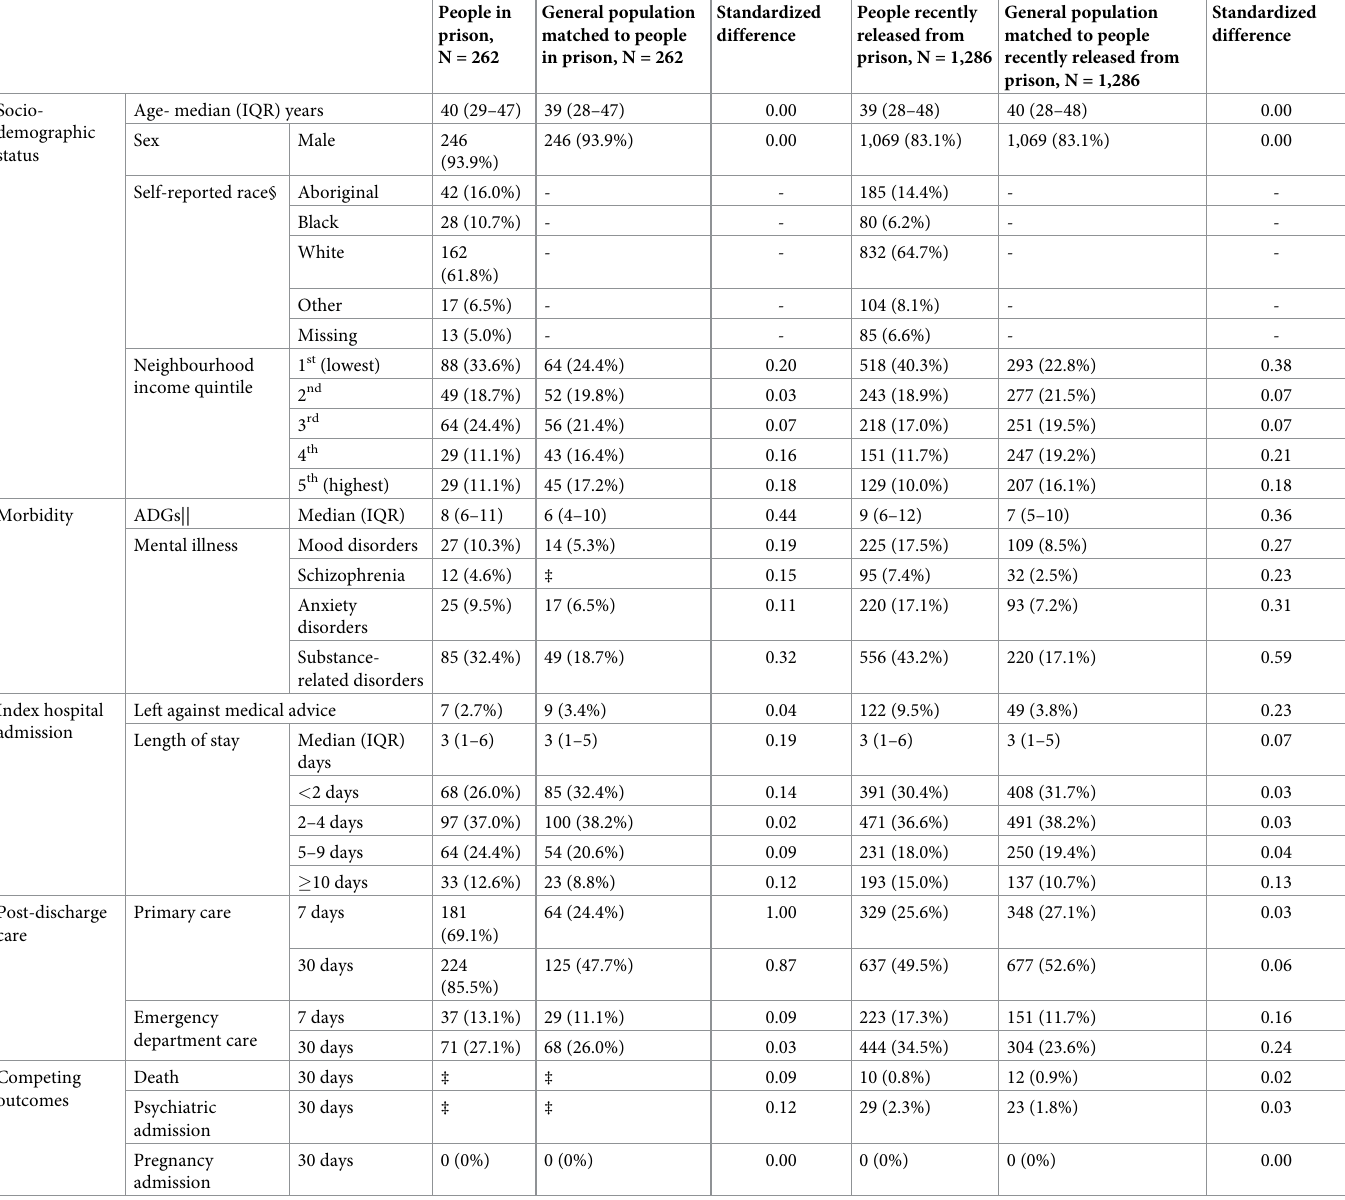
Table 1. Characteristics of study participants at the time of admission for medical-surgical hospitalization between 2005 and 2015 in Ontario, Canada, by imprison- ment status on hospital discharge � †.